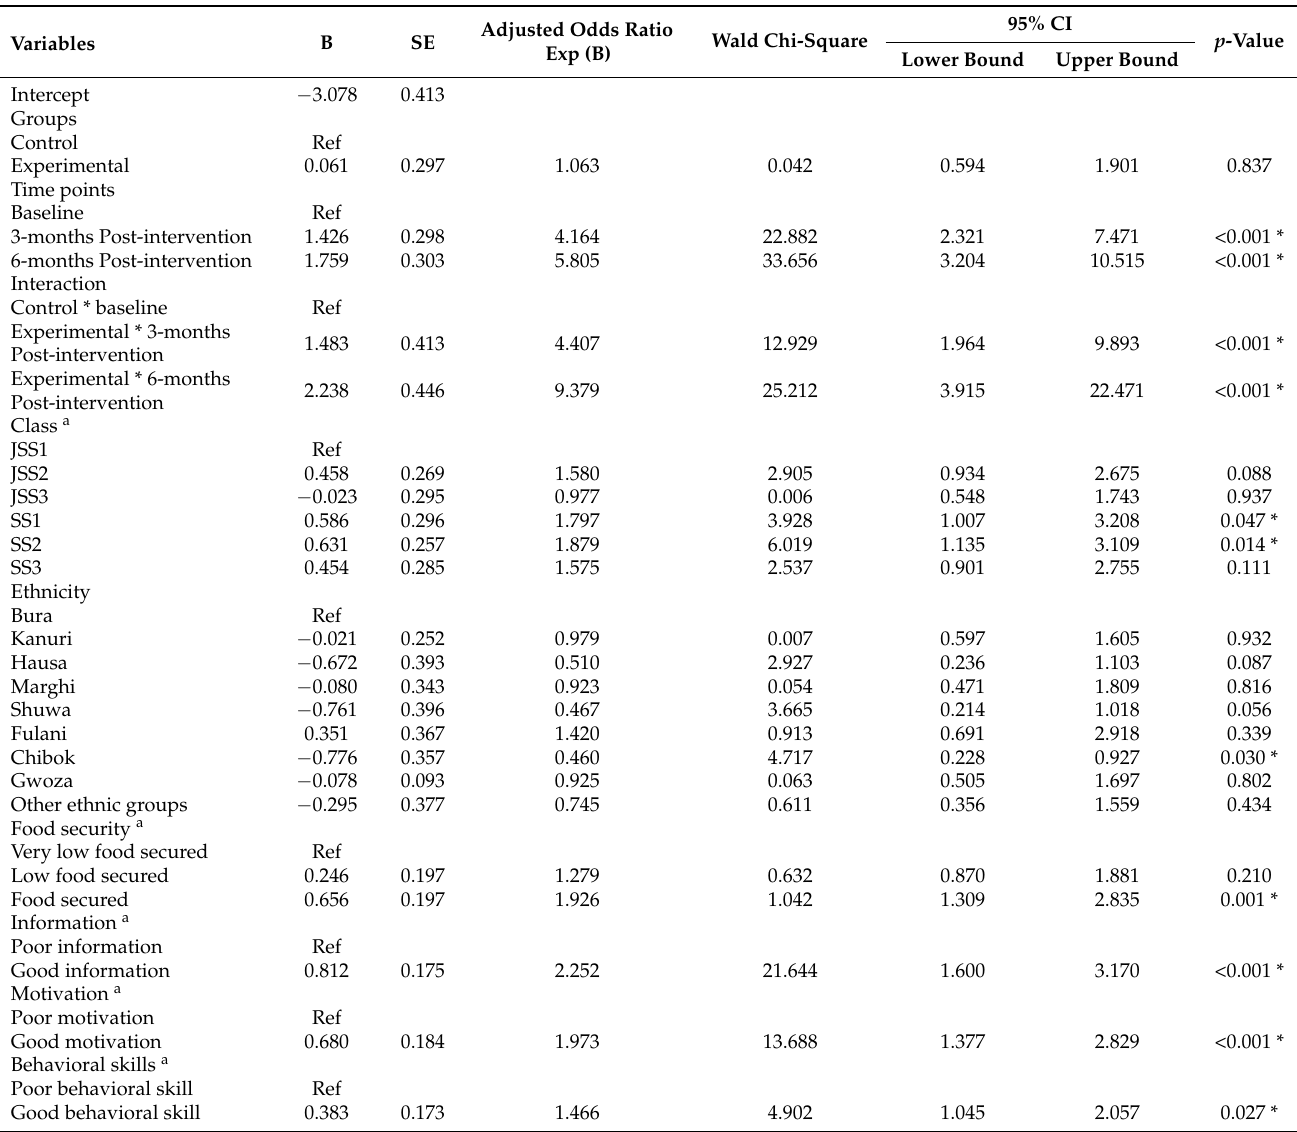
Table 5. Effectiveness of Triple Benefit Health Education Intervention on Knowledge towards Malnutrition between Groups and Time Points (baseline, 3 and 6-month post-intervention) adjusted with Covariates using